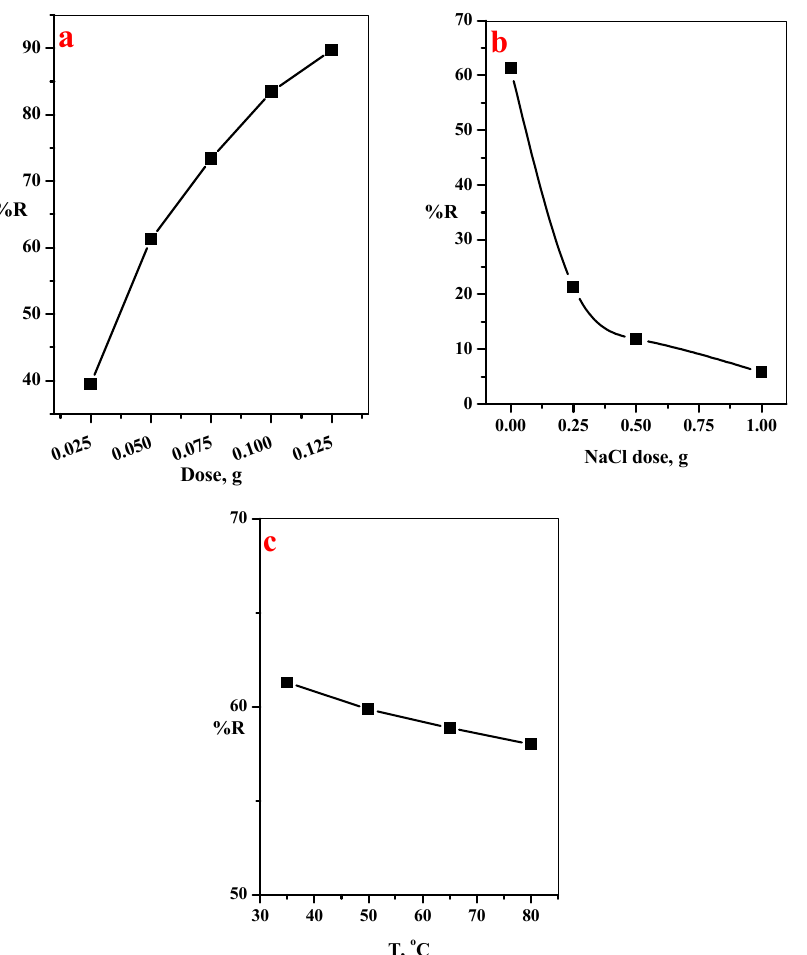
Figure 8. Effect of ( a ) GO@CS beads dose/50 mL dye solution (t = 35 min, [MB] = 20 mg/L, pH = 7,